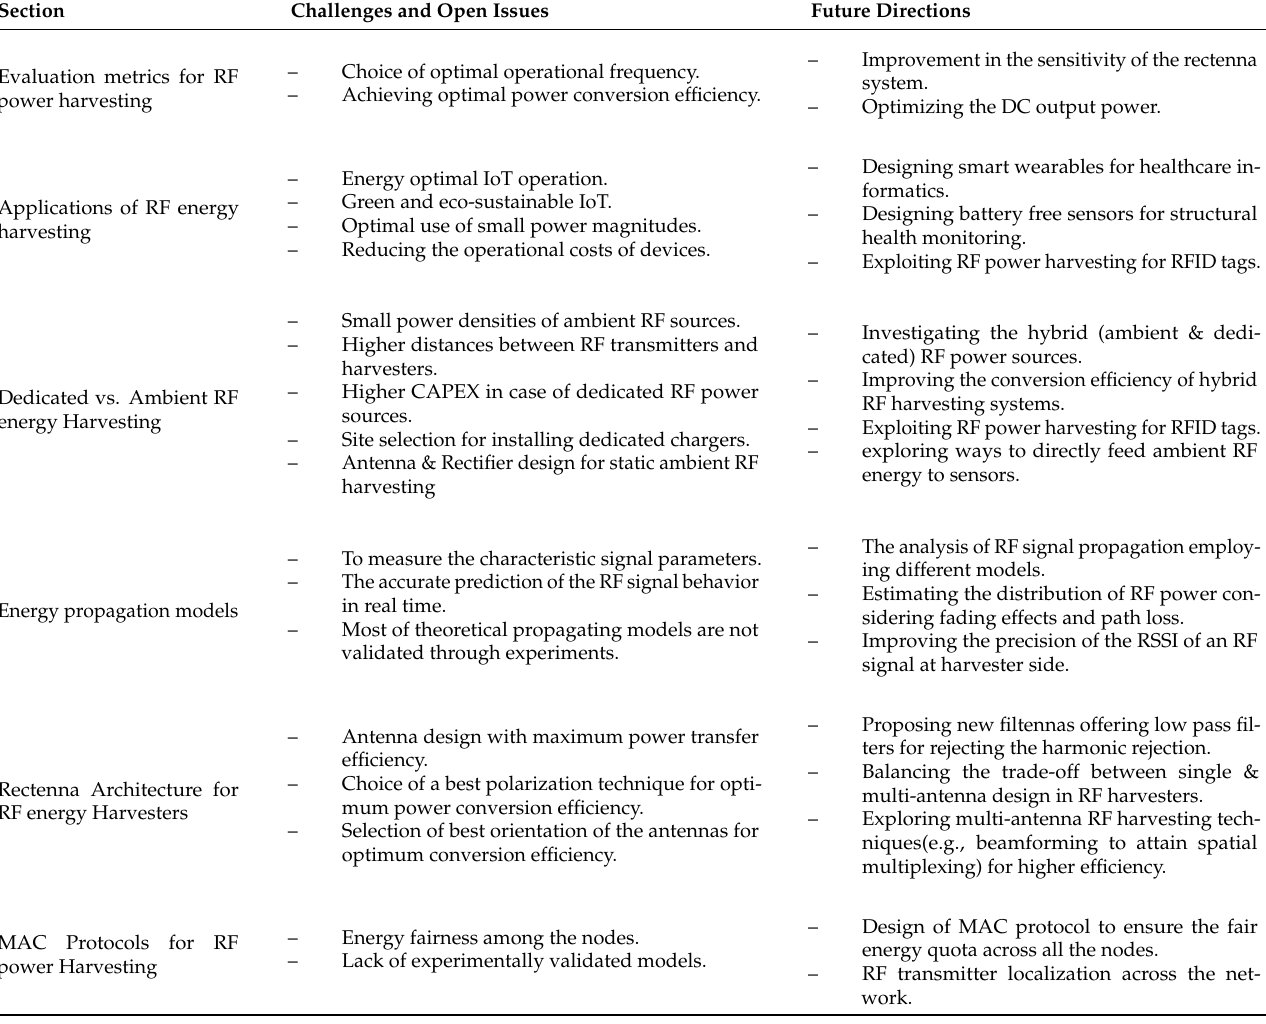
Table 9. Challenges and future research directions in RF power harvesting